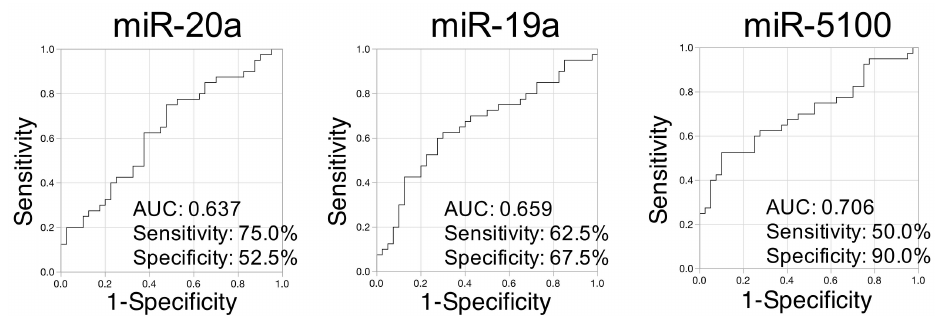
Figure 4. Receiver operating characteristic (ROC) analyses for miR-20a, miR-19a, and miR-5100 indicating a relatively higher area under the curve